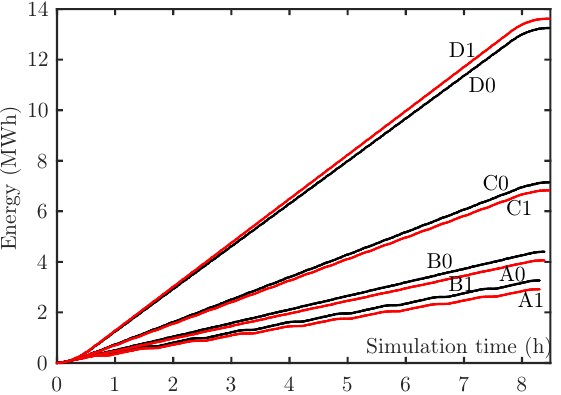
Figure 7. Energy in MWh obtained from the AC grid by substation S5 on the red line for all scenarios. In Figure 8, we represent the Marey diagrams of each scenario just for the red line. The horizontal axis represents time; in this case, we represented the first 80 min of simulation. In the vertical axis, we represent the position of the train. Solid black lines represent trains from S1 to S6, while dashed-dotted lines represent trains circulating from S6 to S1. Vertical red lines represent the instants at which all the substations were blocked at the same time. It must be noticed that in light, medium, and dense traffic scenarios, the percentage of instants in which all substations were blocked at the same time dropped drastically when we added on-board energy storage systems, improving this percentage by more than 10%. However, in the heavy traffic scenario, the percentage of blocking instants was already very low (5%) in the case without on-board accumulation. The installation of on-board accumulation in the heavy traffic scenario produced the blocking of all substations in only 0.8% of the cases.